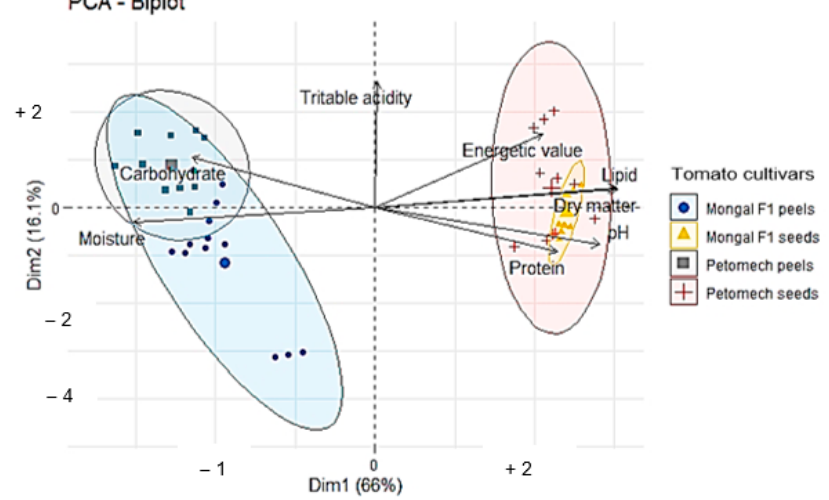
Figure 8. Biochemical parameters clustering according to cultivars.